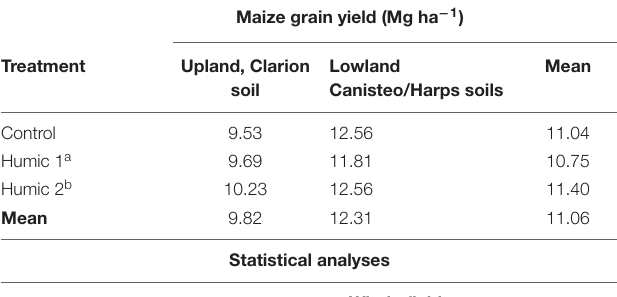
TABLE 3 | Maize grain yield responses to humic product application for the 2013 Kelley on-farm field trial, extracted as georeferenced data from a combine yield map and shown by three soil type/landscape positions.